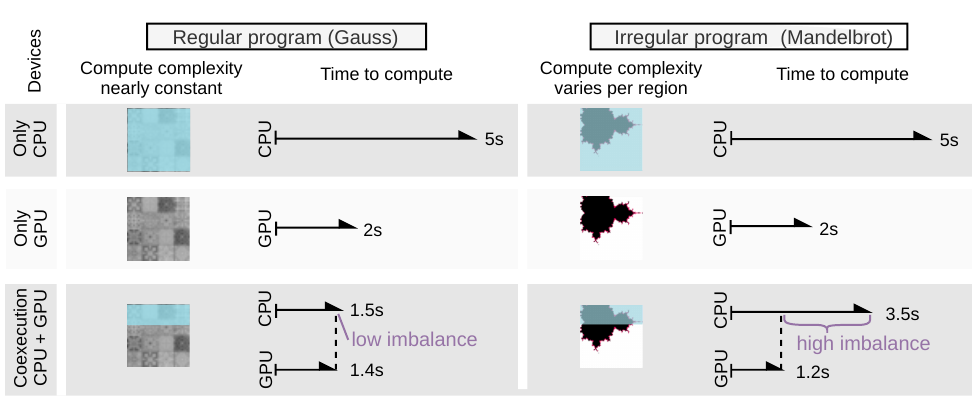
Figure 1. Static co-execution for regular and irregular